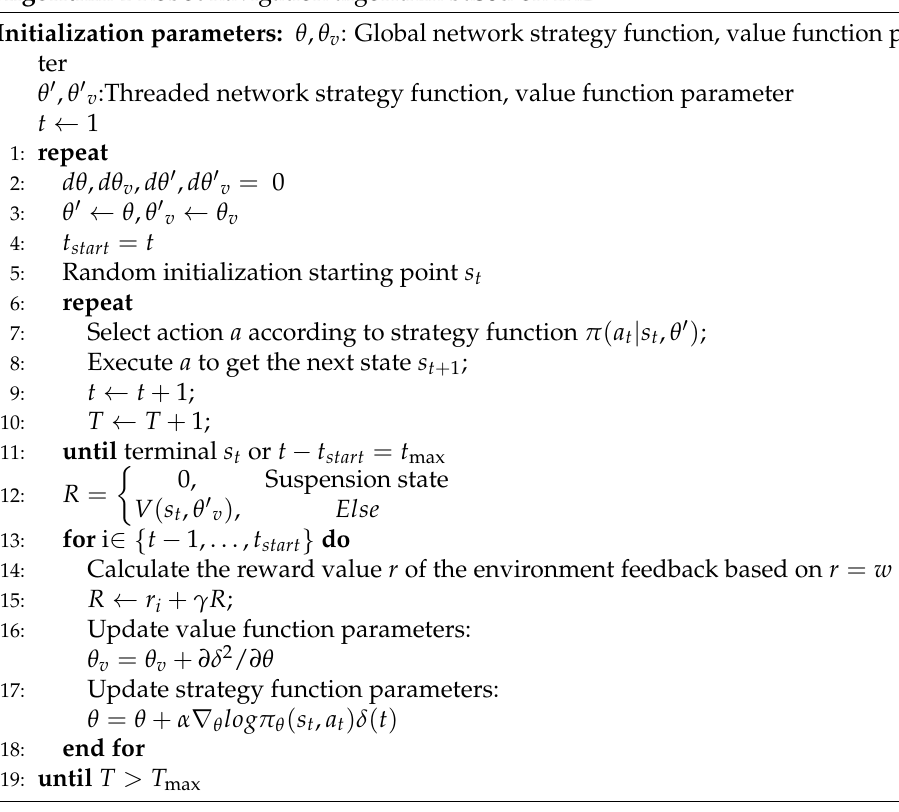
Algorithm 1 Robot navigation algorithm based on